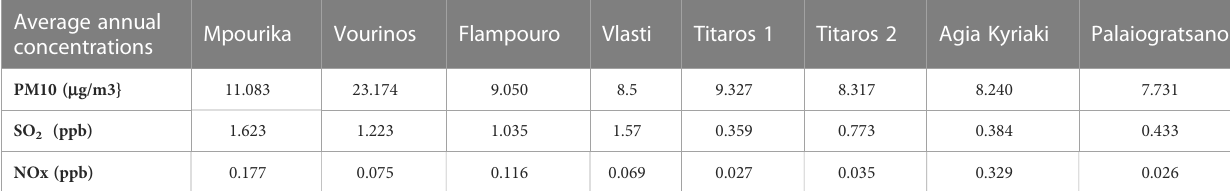
TABLE 1 Average annual concentrations predicted by the TAMP model, for PM10, SO2 and NOx, for eight sites that host natural Pinus nigra populations in the Amyntaio-Ptolemaida-Kozani basin (APKB), Western Macedonia,